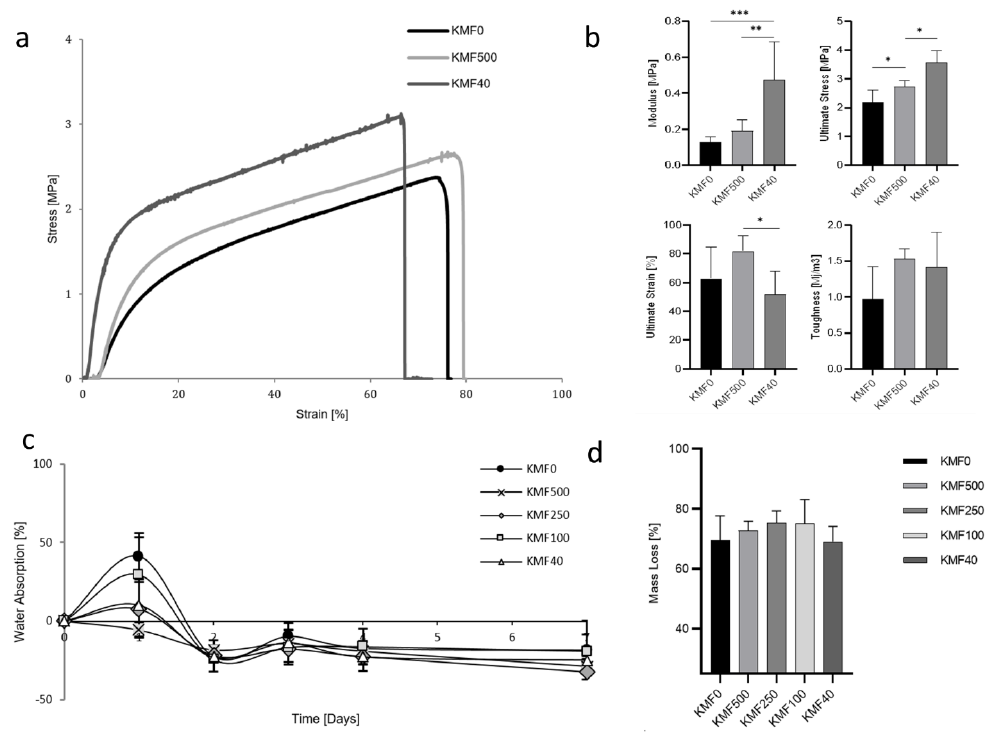
Figure 3. Mechanical properties and water stability of KMFs: ( a ) stress–strain curves of KMF0, KMF500, and KMF40. ( b ) Mechanical parameters: Young’s modulus, ultimate stress, ultimate strain, and toughness of KMF0, KMF500, and KMF40 and their statistically significant di ff erences (* p < 0.05, ** p < 0.01, *** p < 0.001). ( c ) Water absorption over one week of KMFs submersion in water. ( d ) Mass loss of dried KMFs after immersion in water for one week. Table 1. Concentration of aqueous keratin / melanin after film submersion / removal over one week. Keratin [%] Melanin [%]